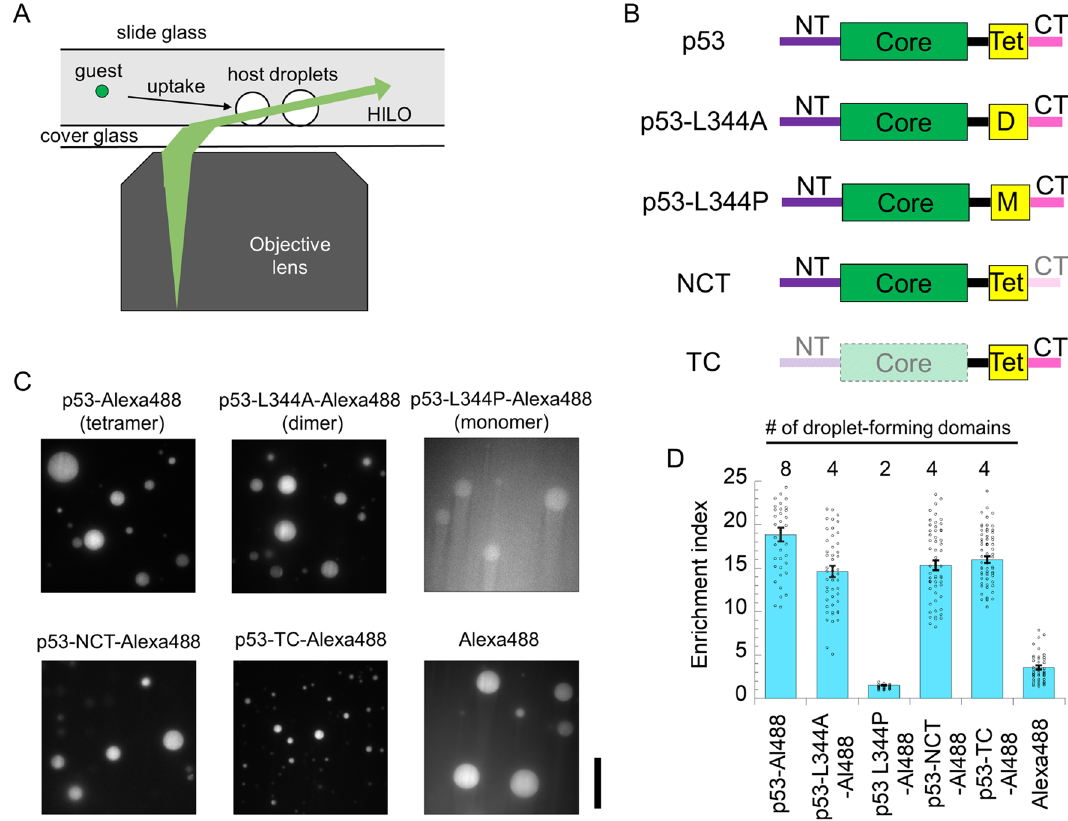
Figure 1. At least four sets of droplet-forming disordered p53 domains are required for recruitment into liquid p53 tetramer droplets. ( A ) Schematic diagram of fluorescent microscopic measurements with highly inclined and laminated optical sheet (HILO) illumination for labeled guest proteins in non-labeled host protein droplets. ( B ) p53 mutants used in the study. NT, core, Tet, and CT represent the N-terminal, core, tetramerization, and C-terminal domains of p53, respectively. D and M represent dimer and monomer mutations in Tet domain, respectively. Green and yellow boxes represent folded regions, whereas the other colors (purple, black, and pink) represent disordered regions. ( C ) Fluorescent images of Alexa488-labeled p53 mutants with different oligomeric states in non-labeled p53 tetramer droplet solution. Scale bar denotes 20 μm. ( D ) Enrichment index (EI) of the guest p53 mutants into non-labeled p53 tetramer droplet. Dots represent the average EIs of each droplet. The errors denote the standard errors. Al488 denotes Alexa488. # of droplet-forming domains denotes the number of NT plus CT. Significant differences in average EI values between p53-Alexa488 and four p53 mutants were confirmed using Welch’s t test with α = 0.05. Significant differences were also confirmed in average EI values between Alexa488 and five p53